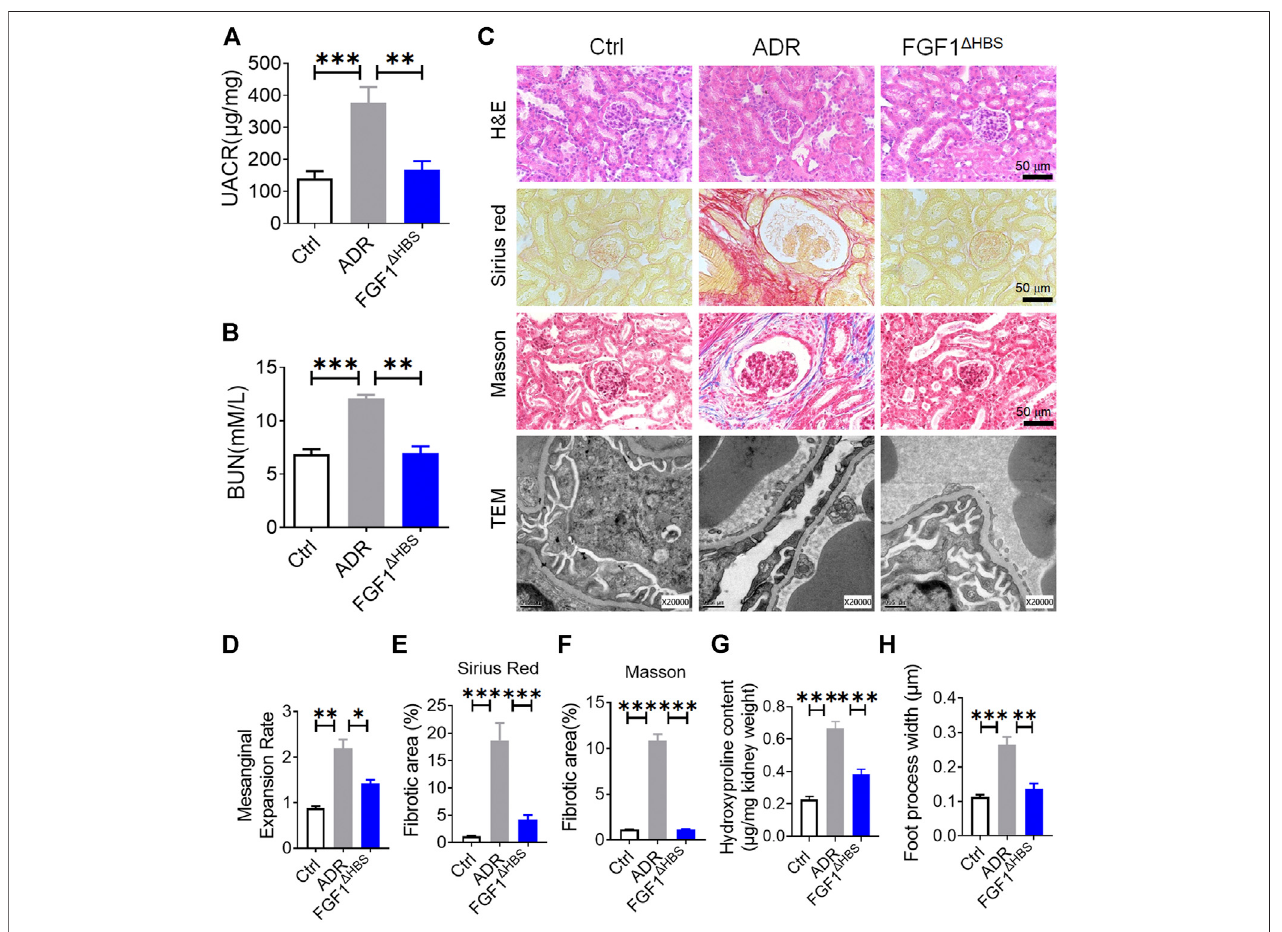
FIGURE4| FGF1 Δ HBS inhibitedADR-inducedrenalremodelinganddysfunction. (A) Urinealbumin-to-creatinineratio(UACR). (B) Bloodureanitrogen(BUN)levels. (C) Representativeimagesofhematoxylinandeosin(H&E)staining,Siriusredstaining,Masson ’ strichromestaining,andtransmissionelectronmicroscopy(TEM)images of renal tissues. (D) Quanti fi cation of mesangial expansion. (E) Quanti fi cation of the fi brotic area in Sirius red staining. (F) Quanti fi cation of the fi brotic area in Masson staining. (G) Hydroxyproline content in renal tissues. (H) Quanti fi cation of podocyte foot process effacement. Data are presented as the mean ± SEM ( n (cid:1) 6); * p < 0.05, ** p < 0.01, *** p <